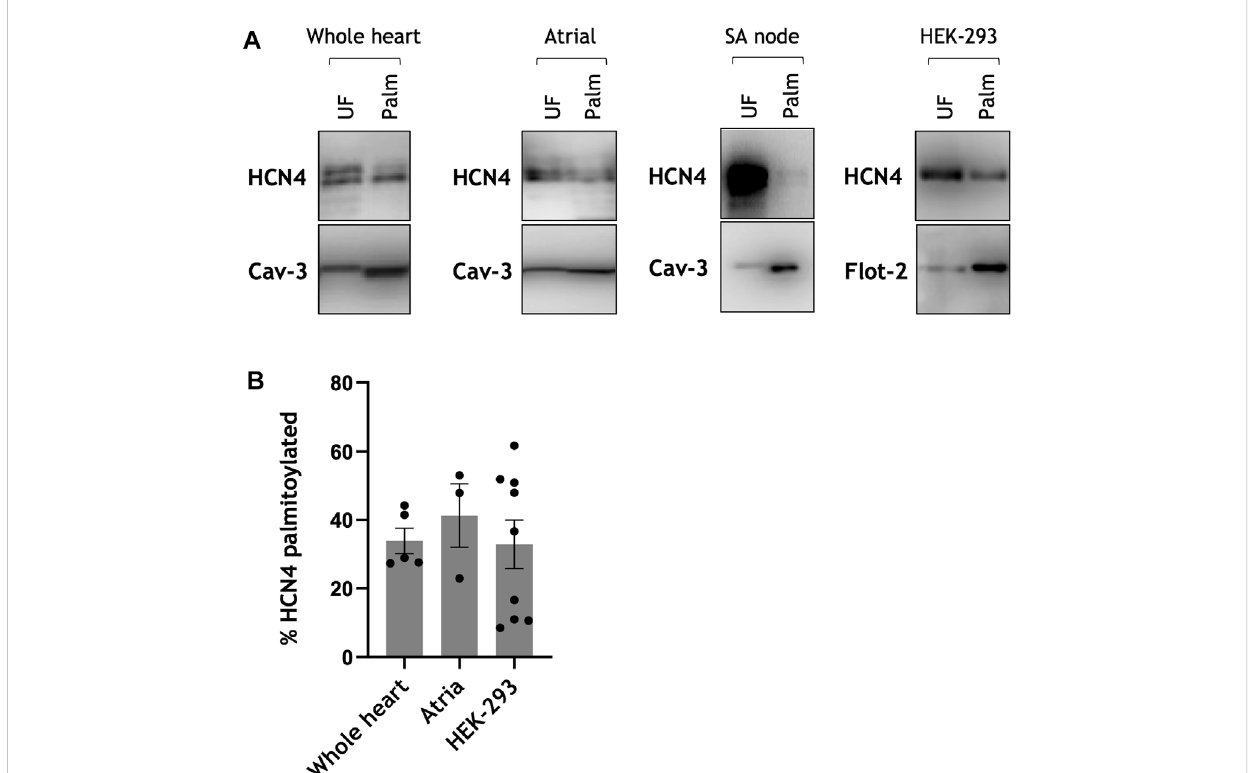
FIGURE 1 HCN4 palmitoylation in cardiac tissue and transfected cells. (A) Palmitoylation of HCN4 assessed using acyl-RAC from isolated rat neonatal whole heart, rat neonatal atria, rabbit sinoatrial node and following transient transfection of HEK-293 cells. The constitutively palmitoylated proteins caveolin-3 (Cav-3) and fl otillin-2 (Flot-2) were used as a marker of assay ef fi ciency. Full length HCN4 was detected with anti-HCN4 antibody. (B) Palmitoylation stoichiometry of endogenous HCN4 in rat neonatal cardiac tissue (whole heart, atria) and transiently transfected cells relative to caveolin-3 and fl otillin-2, respectively. Compared to caveolin-3 the fraction of HCN4 palmitoylated is ~33 ± 4% in rat neonatal whole heart ( n = 5) and ~41 ± 9% in rat neonatalatria( n =3).Comparedto fl otillin-2thefractionofHCN4palmitoylatedinHEK-293cellsis~33±7%( n =9).Eachspotinthebarchartrepresents a measurement made from an independent population of cells. UF: Unfractionated cell lysate; Palm: palmitoylated